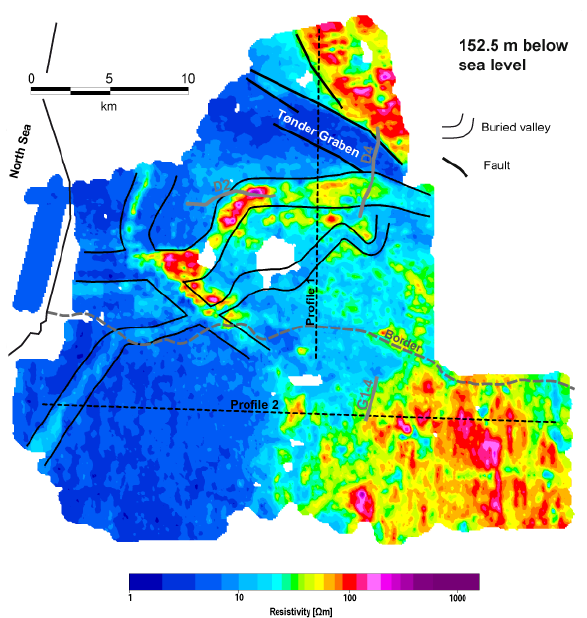
Fig. 9. Horizontal resistivity slice 152.5m below sea level. Faults related to the Tønder Graben are shown with thick black lines. Grey lines depict the seismic lines shown in Figs. 6, 7 and 8. Location of the two SkyTEM profiles 1 and 2, shown in Fig. 11, are marked with dashed lines. Some of the deeper buried valleys are delineated, but not necessarily expressed in the resistivity data at this specific